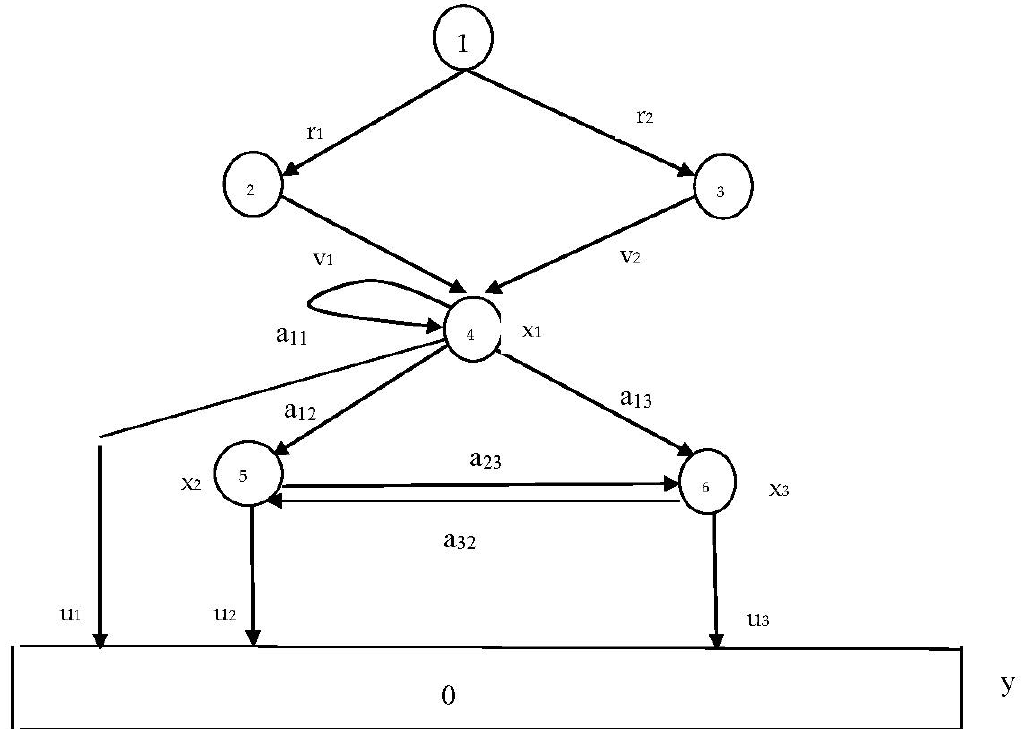
Figure 2. A model example of an active opinion control network.